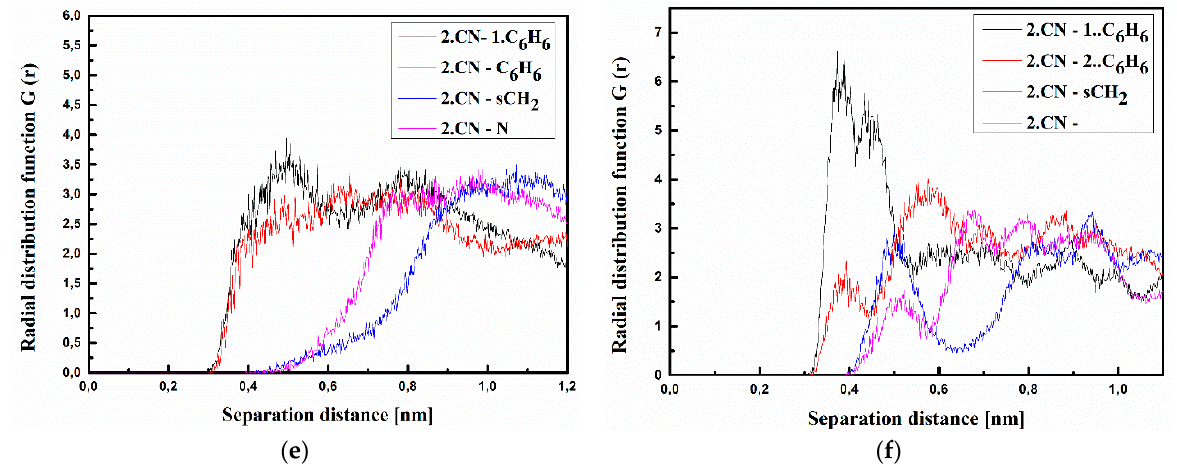
Figure 6. Partial RDFs calculated for distances between the center of mass of different moieties of the A molecule and different subunits of PVK at T = 500 K ( a , c , e ) and T = 300 K ( b , d , f ) for the thin film composite system. The RDFs are presented for methyl group (Me) of A molecule and different subunits of PVK mer ( a , b ); for cyanovinyl CN1 at the side of the molecule A and different subunits of PVK mer ( c , d ); and cyanovinyl CN2 at the back of the molecule A and different subunits of PVK mer ( e , f ).